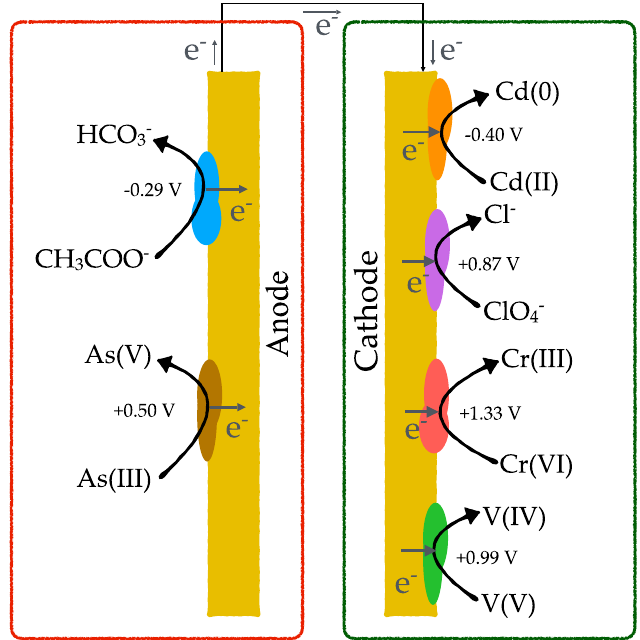
Figure 1. Scheme of the bioelectrochemical reactions involving the considered contaminants and their redox potentials. In the figure, microorganisms catalyze the reactions at both anode and cathode; cathodic reaction may also occur at an abiotic cathode. The redox potentials (E 0 ) in the figure are under standard conditions and arevreferred to the standard hydrogen electrode (SHE); the sources for the values are listed below: CH 3 COO − /HCO 3 − : reference [48]; As(III)/As(V): references [49,50]; ClO 4 − /Cl − : reference [51]; Cr(III)/Cr(VI): reference [52]; V(V)/V(IV): reference [53]; Cd(II)/Cd(0): reference